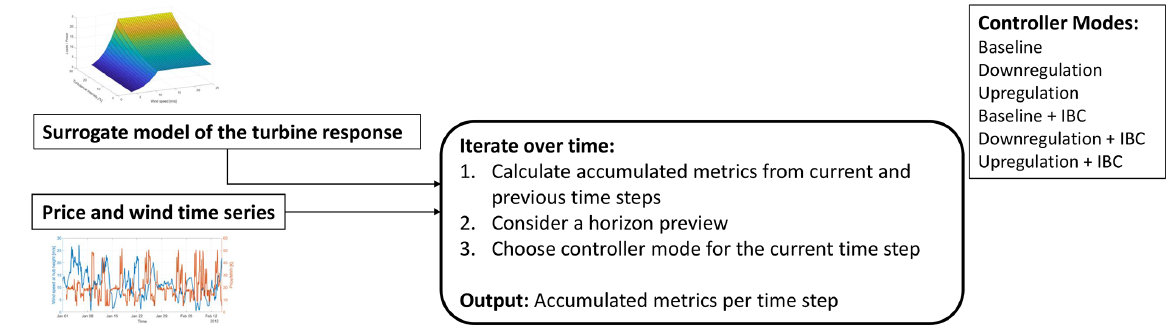
Figure 2. Proposed methodology for flexible control operation of a single wind turbine developed and applied by participant P1. IBC: indi- vidual blade pitch